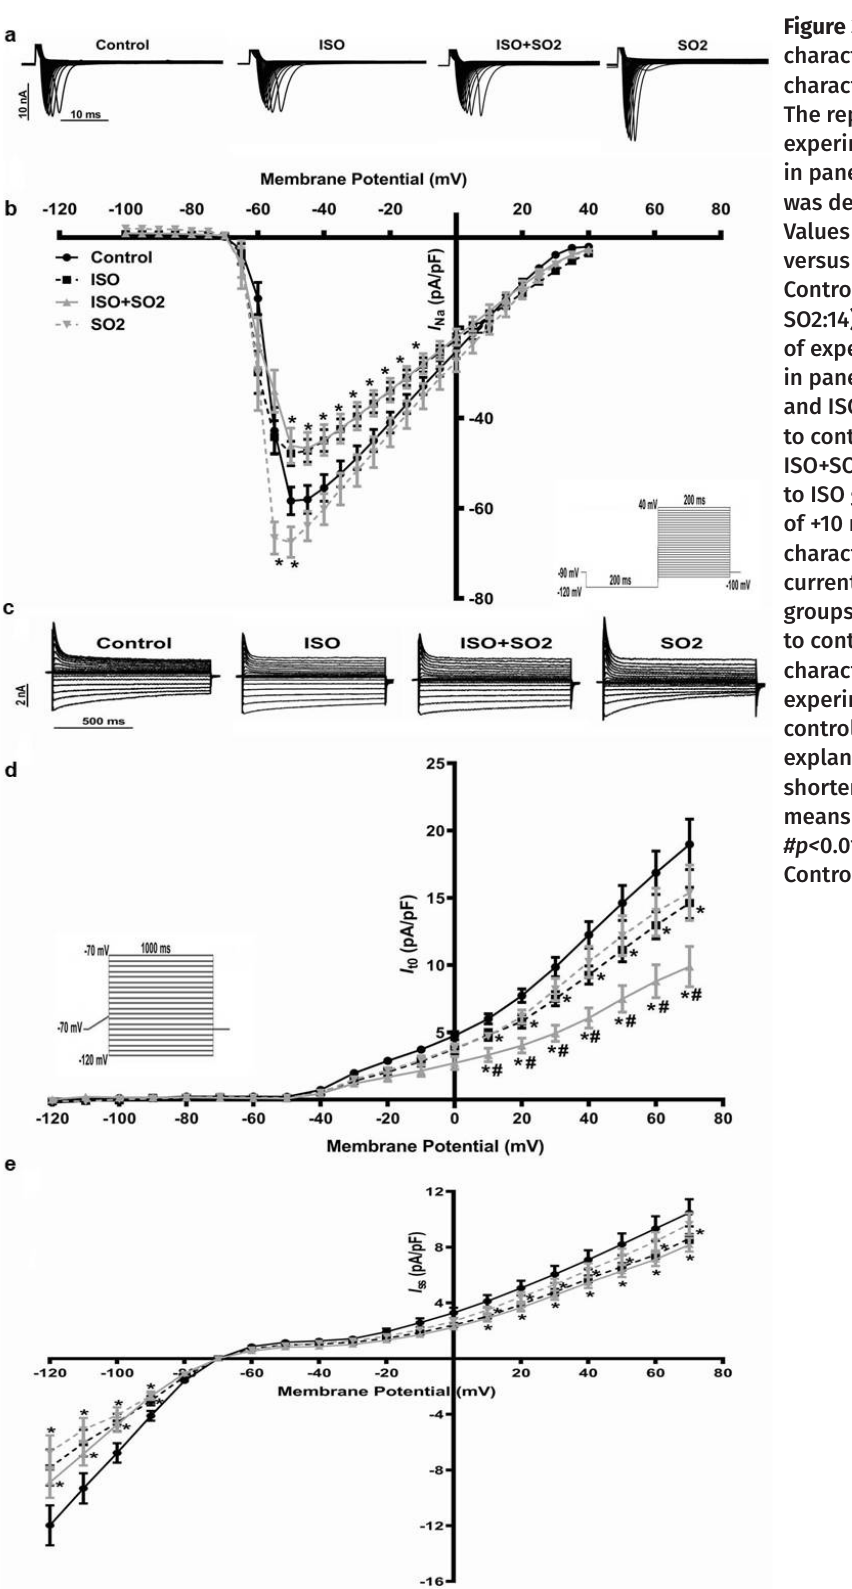
and voltage Na , I and I . to ss K1 traces of Na